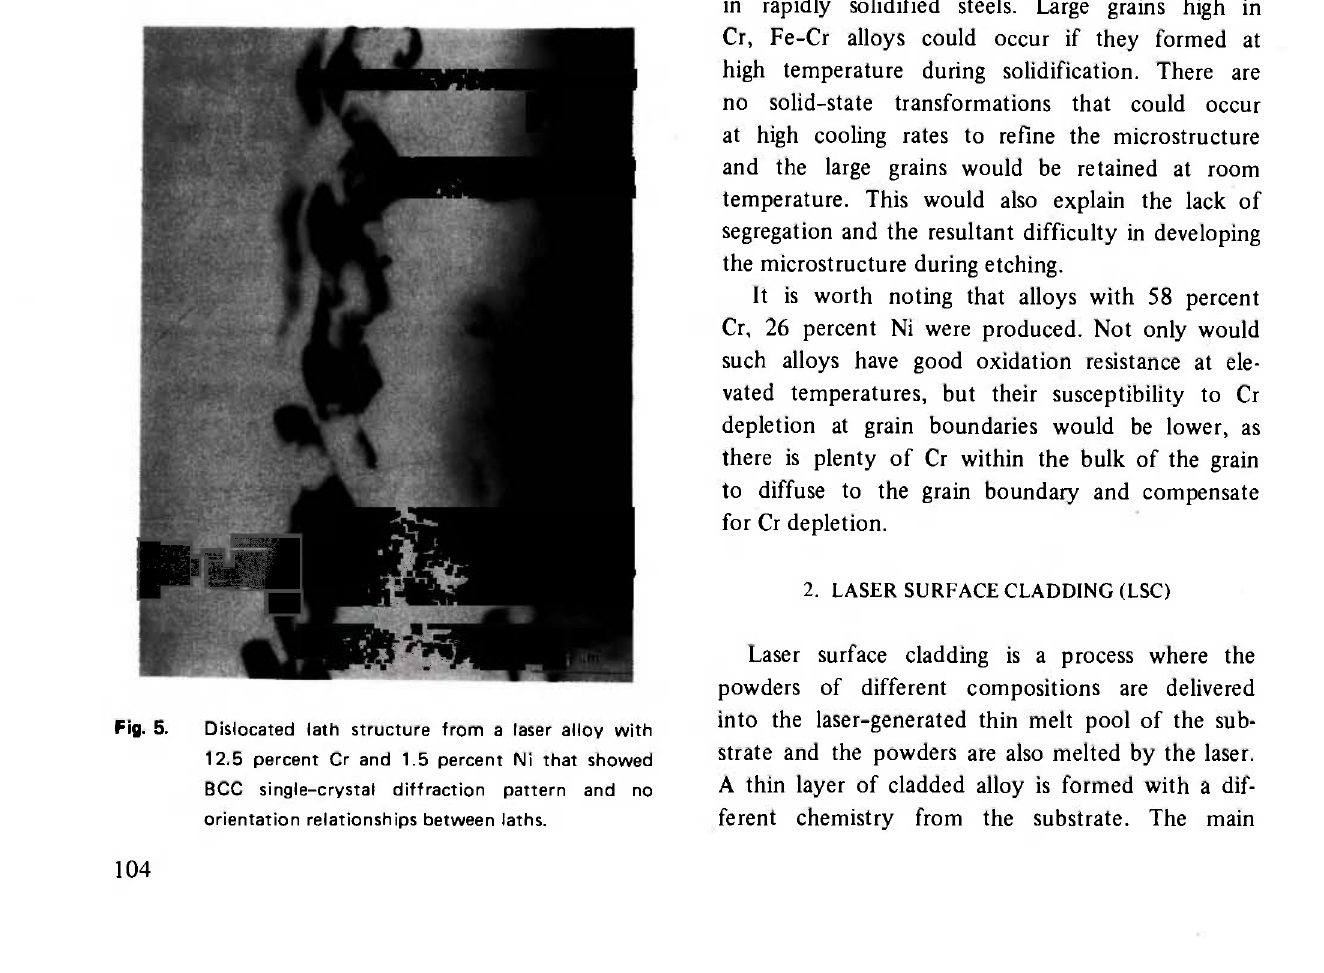
Fig. 4. Cr-rich grain boundary precipitates at a depth below 375 ß.m from the surface in sample made at 6 kW laser power, 3 mm beam diameter and 10 "7 mm/ς Traverse snperi with Cr nnwrler foorl